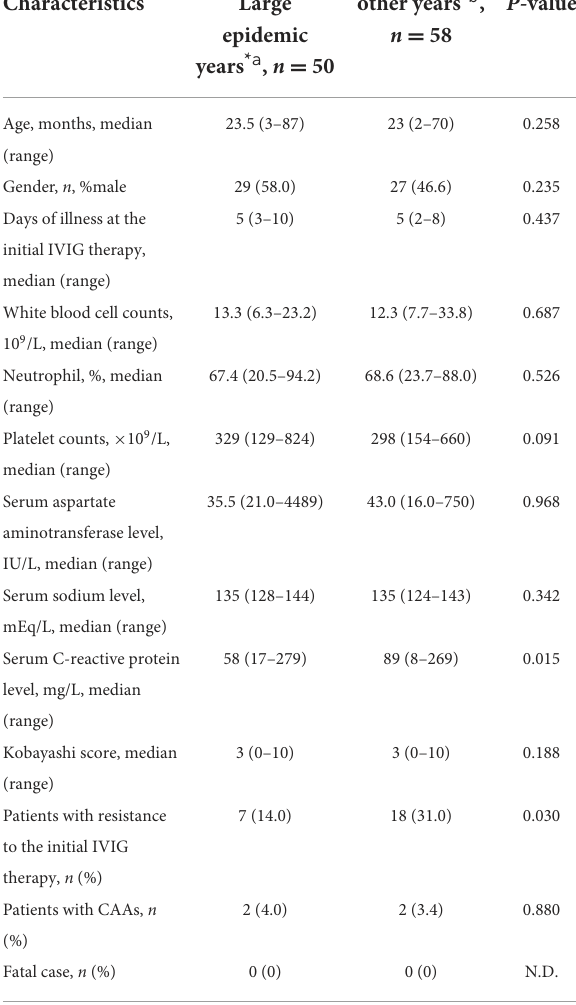
TABLE 2 The comparison of the demographic and clinical characteristics between patients who developed KD during summers in large HFMD epidemic years and those in other years.